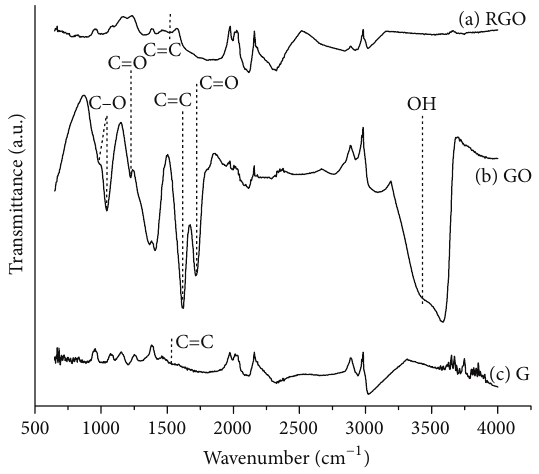
Figure 1: Infrared spectra of (a) reduced graphene (RGO), (b) graphene oxide (GO), and (c) pure graphite